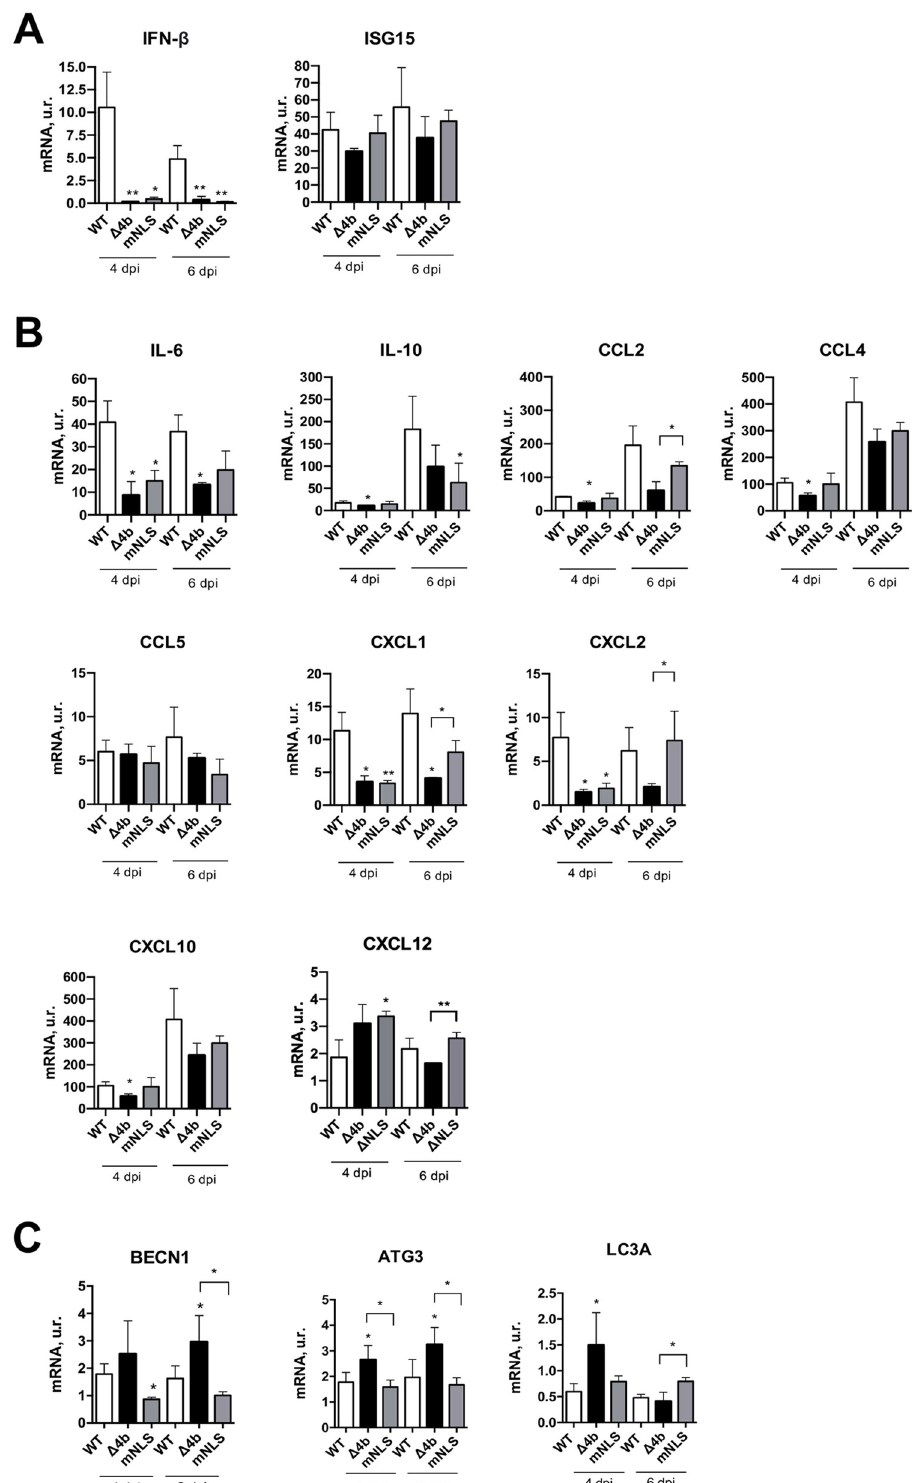
Fig 3. Innate immune response to MERS-CoV-MA- Δ 4b in mice. hDPP4-KI mice were infected with 5x10 4 PFU of MERS-CoV-MA-WT, MERS-CoV-MA- Δ 4b or MERS-CoV-MA-mNLS virus. Mice were sacrificed at 4 and 6 dpi and the RNA of the lungs was extracted for gene expression assays. mRNA expression levels of genes related to the IFN